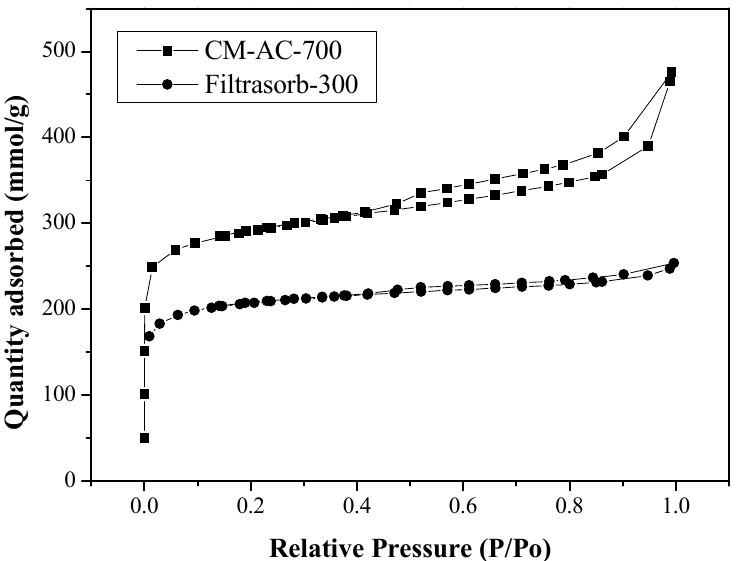
Figure 1. N 2 adsorption-desorption isotherms of cow manure-derived activated carbon (CM-AC) and commercial activated carbon (i.e., Filtrasorb-300).